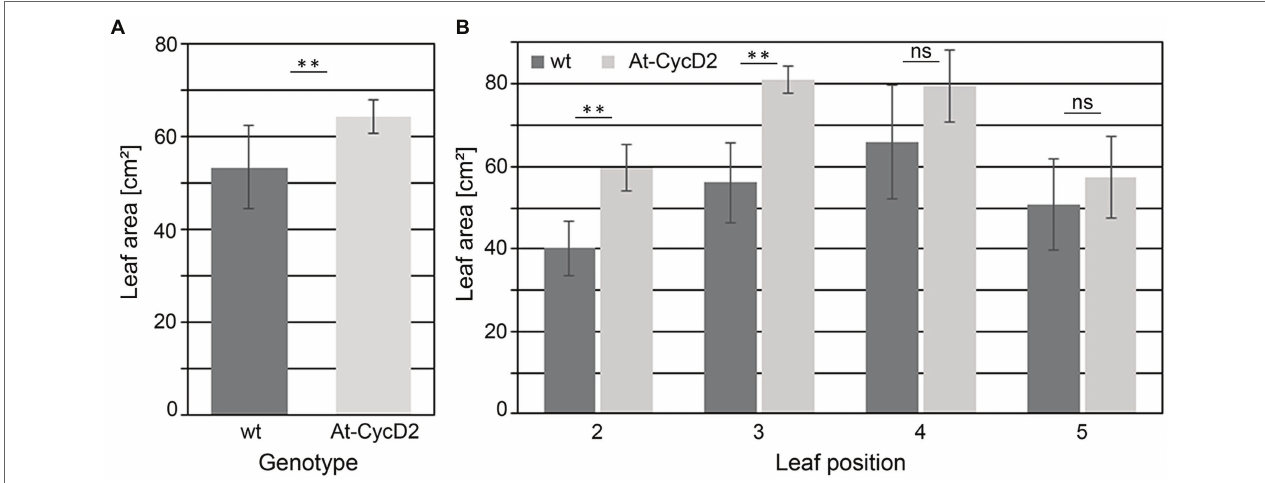
FIGURE 3 | Leaf area of the At-CycD2-15 and wild type (wt) N. benthamiana plants. Leaves 2, 3, 4, and 5 from the soil-grown transgenic At-CycD2-15 and non- transgenic plants were harvested at 4 weeks after planting to measure the leaf area. (A) Total leaf area. The leaf area for leaves 2, 3, 4, and 5 was measured and summarized for each plant. (B) Area of leaves at different positions. Values represent the means with standard deviation ( n = 8). Asterisks indicate significance as determined by the Mann–Whitney test, with ** denoting p < 0.01. Not significant values are determined as